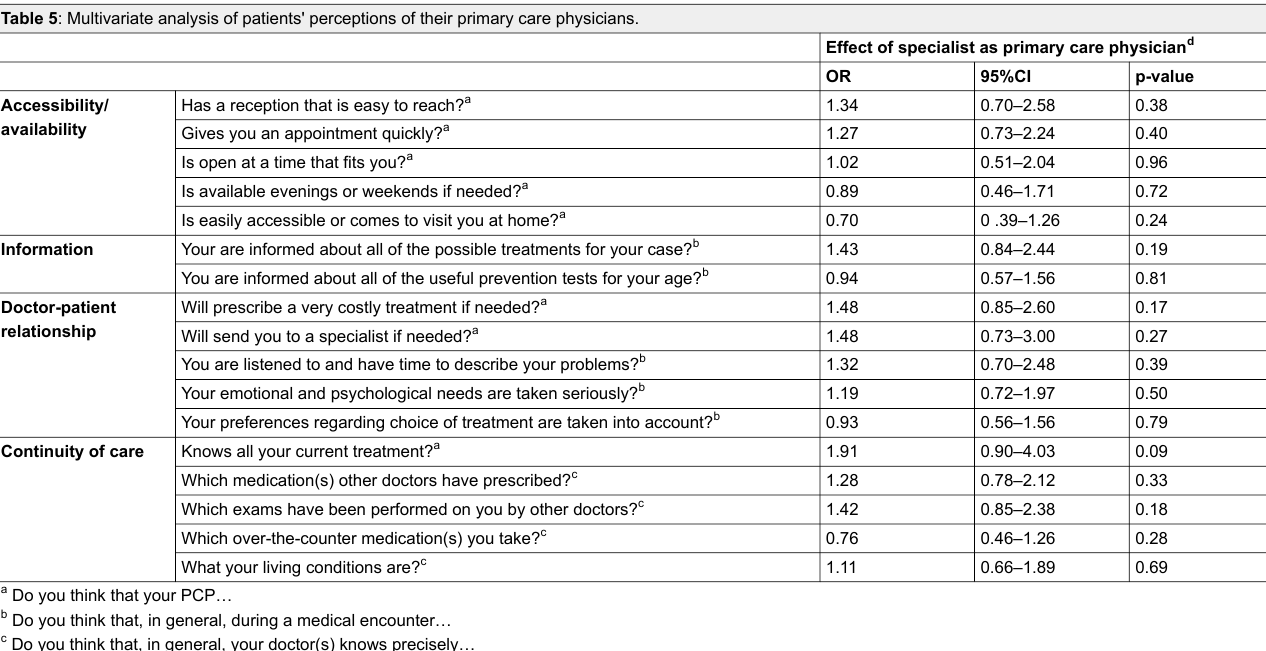
Table 5 : Multivariate analysis of patients' perceptions of their primary care